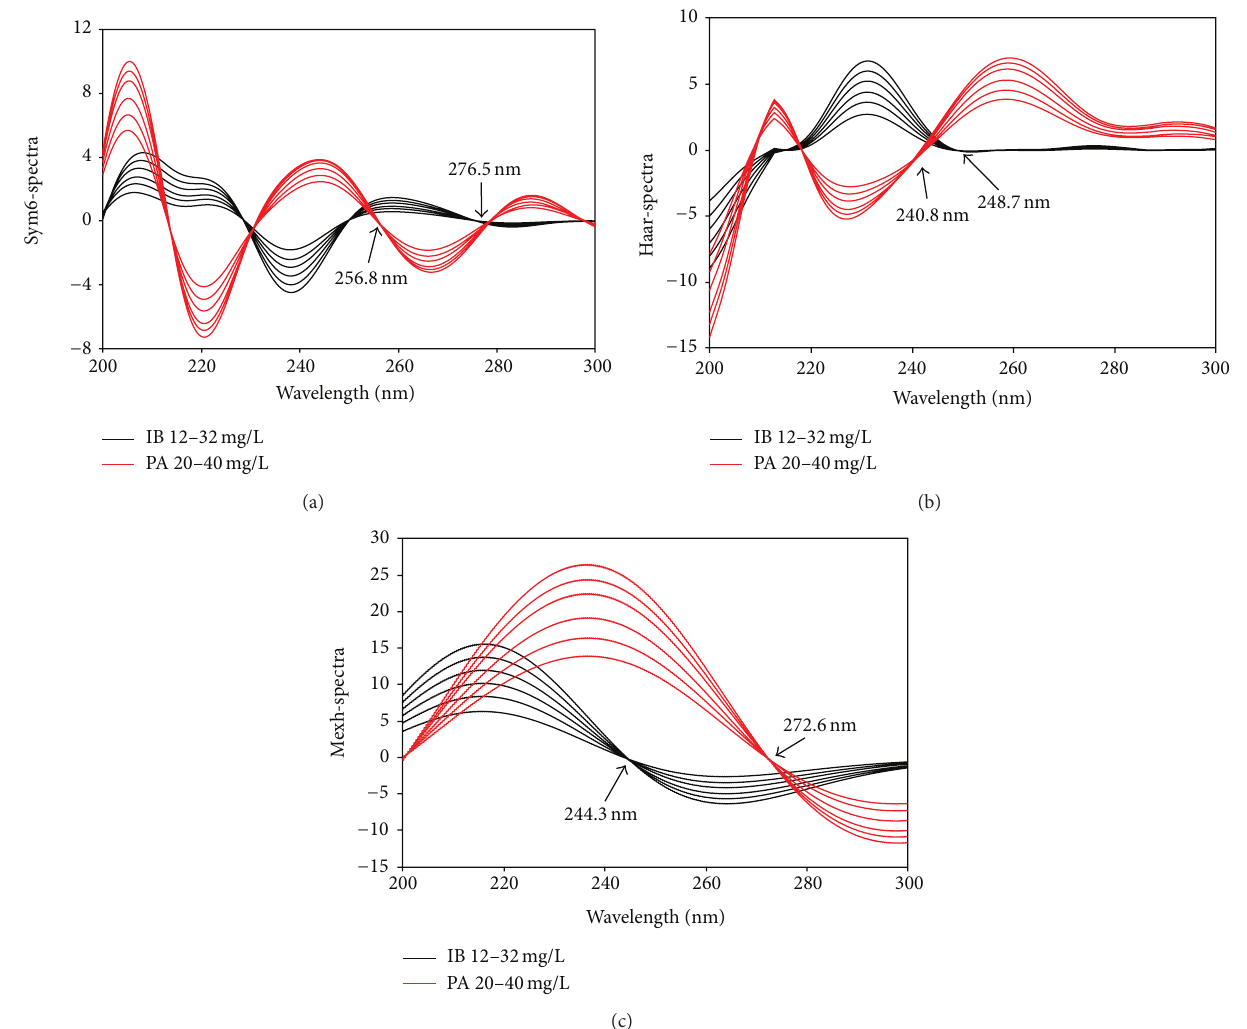
Figure 5: Wavelet transform of spectra using sym6 (a), haar (b), and mexh